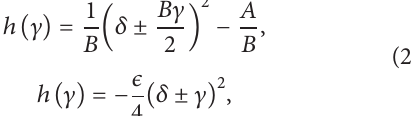
Table 3: Subalgebras, group invariants, and group-invariant solu- tions of (2). 𝑁 𝑋 𝛾 Group-invariant solution